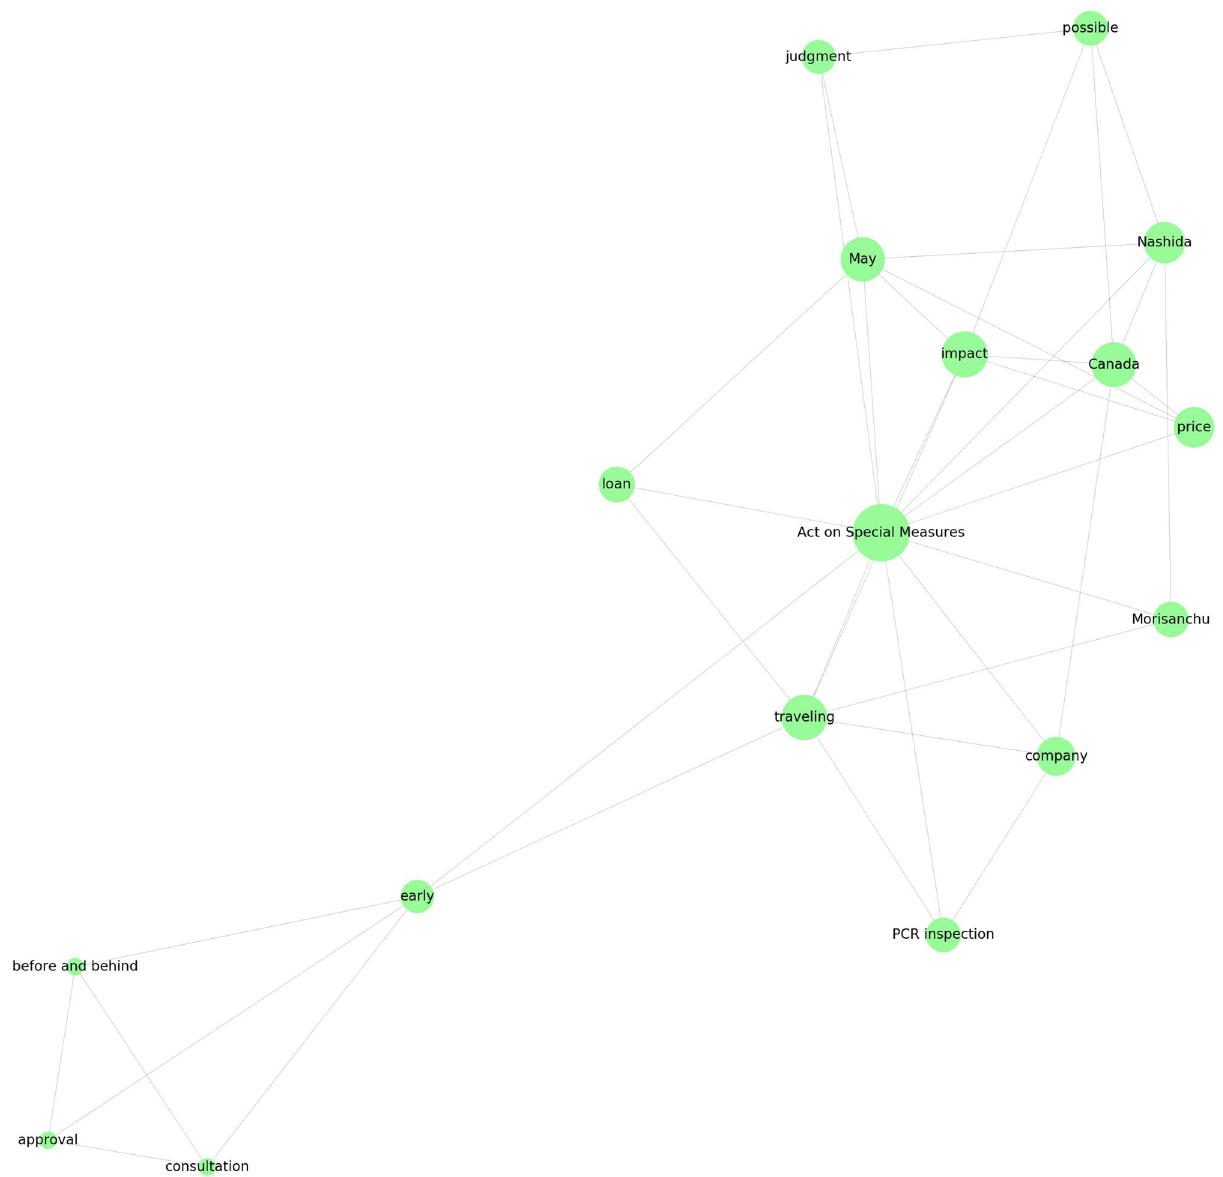
Figure 4. Third trend cluster in Fig. 1a. The words corresponding to each trend are shown.